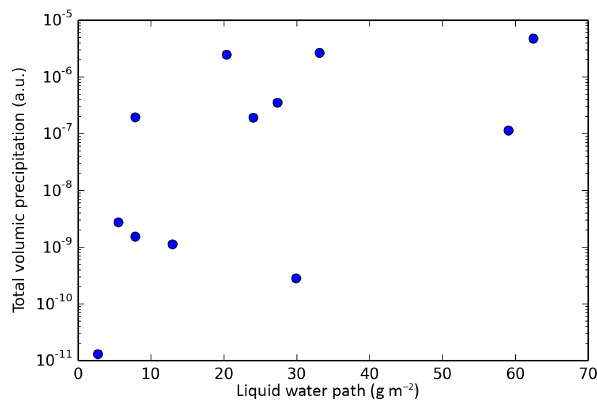
Figure 6. Figure resulting from the example code at the end of Sect. 5.2. Here, we plotted an indicator of the drizzle volume in a vertical profile as a function of the liquid water path. This is only an example; many other possibilities